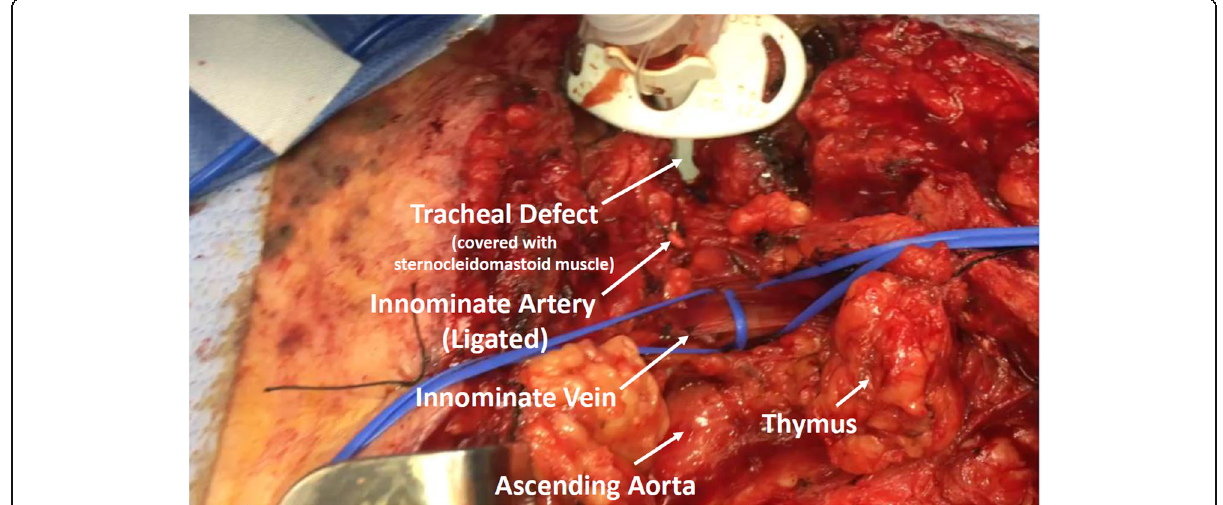
Fig. 1 Identification of anatomy with partial closure with the sternocleidomastoid